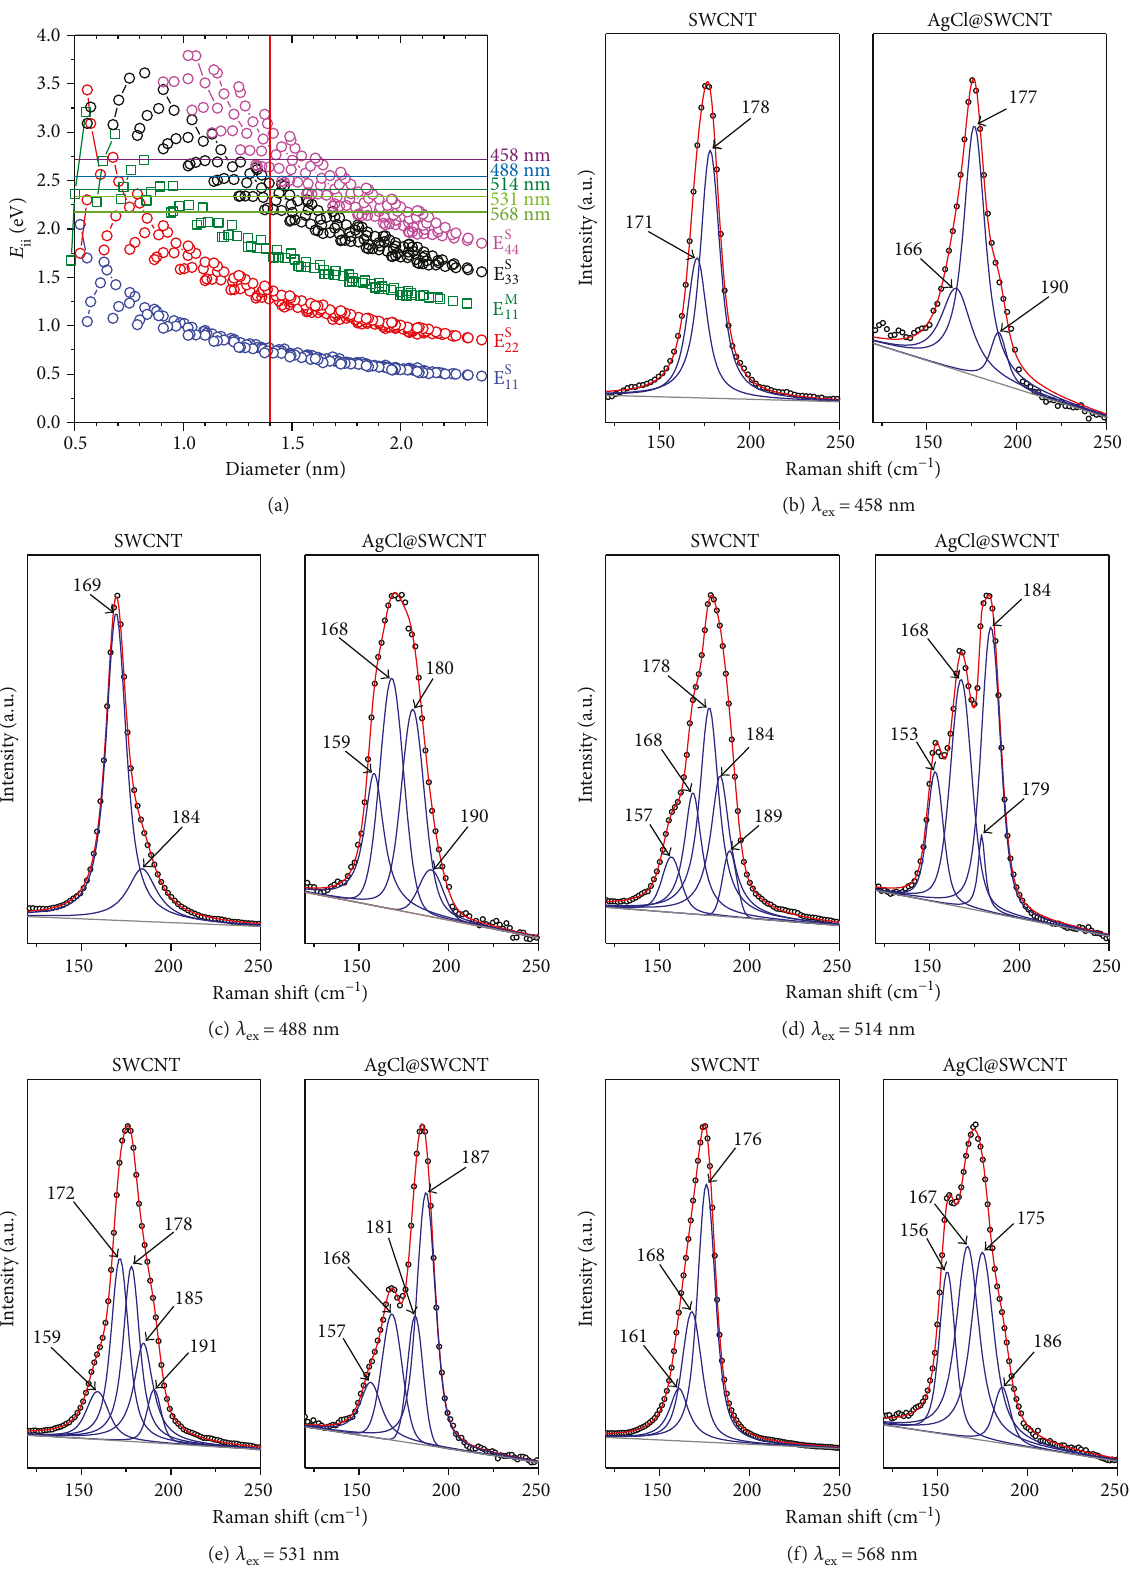
Figure 3: (a) The Kataura plot (replotted from [28]), where the laser wavelengths used for Raman spectroscopy and mean diameter of SWCNTs are denoted. (b – f) The RBM-bands of Raman spectra of the pristine and AgCl- fi lled SWCNTs fi tted with individual components. The positions of the maxima of components are